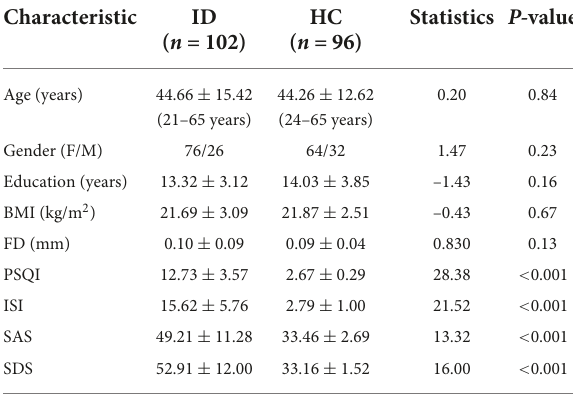
TABLE 1 Demographic and clinical characteristics between insomnia disorder (ID) and healthy controls groups.